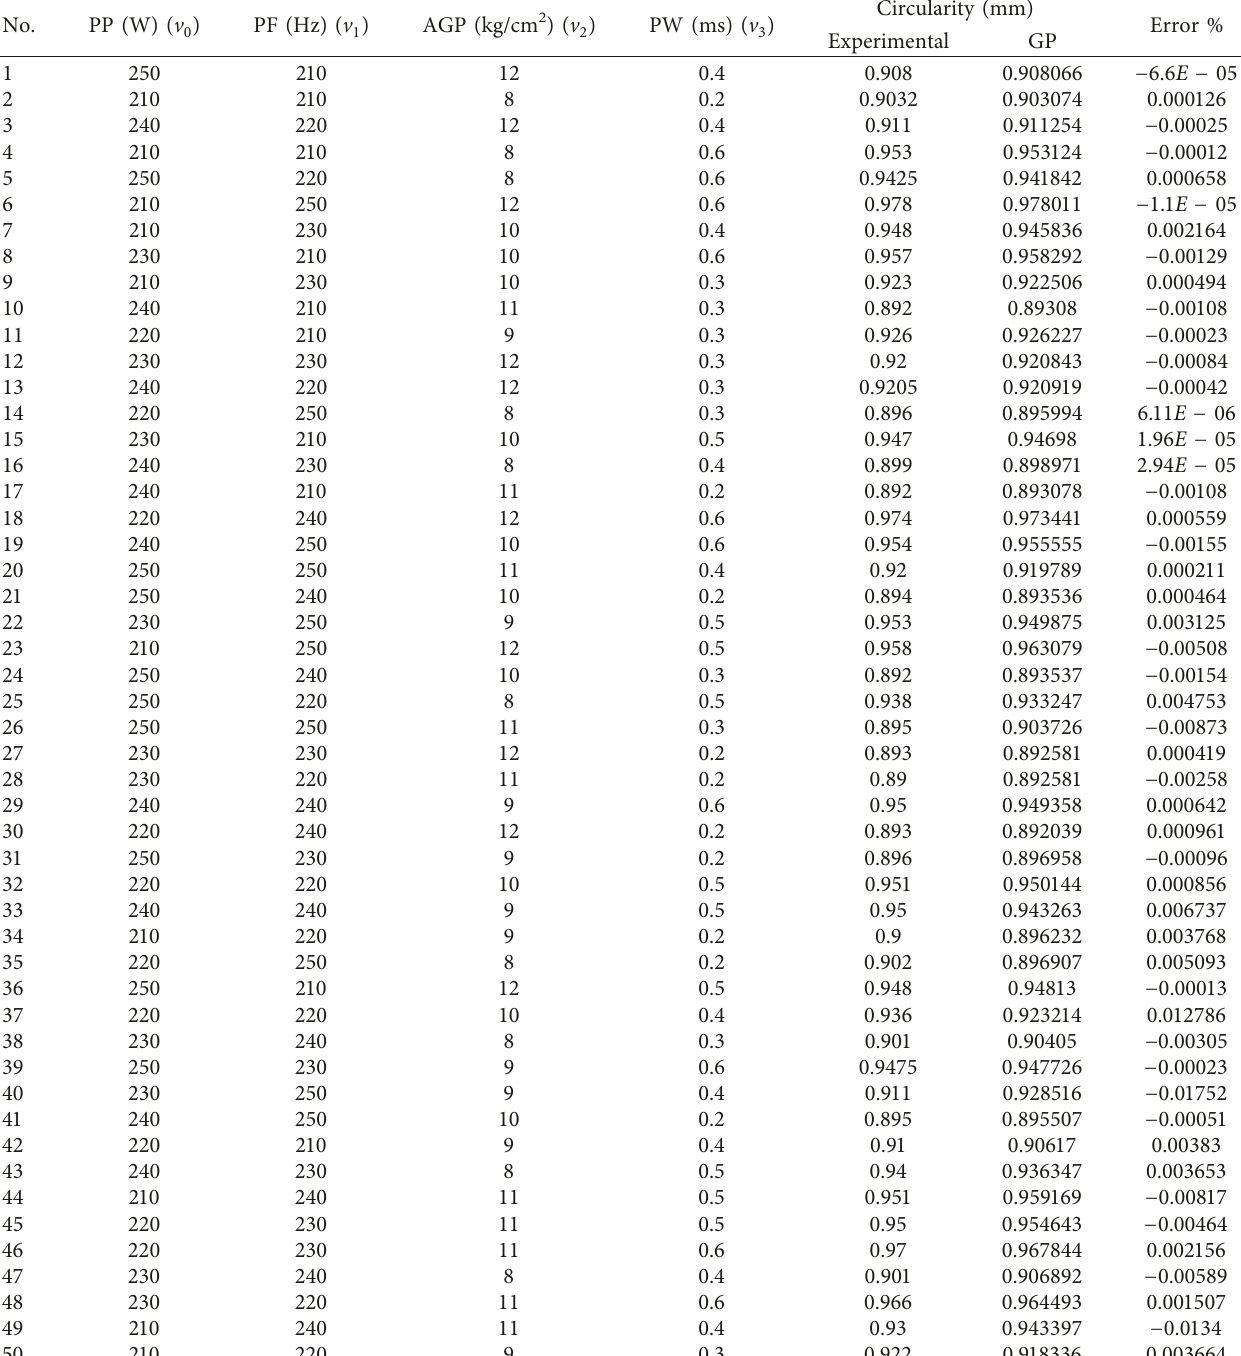
Table 2: Comparison between experimental and predicted values of circularity at R 2 �